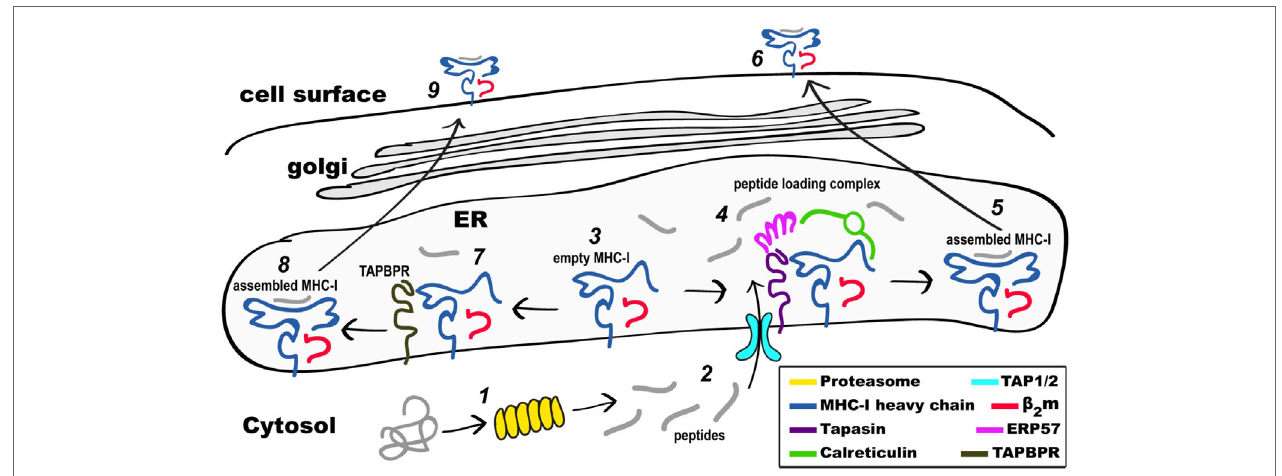
FiGURe 1 | Schematic view of MHC class I (MHC-I) pathways of antigen processing and presentation. Proteins in the cytosol engage the proteasome (1) and the peptides generated (2) are transported through the TAP1/2 transporter to the endoplasmic reticulum (ER). Partially folded MHC-I/ β 2-microgolobulin ( β 2 m) complexes (3) are stabilized as part of the peptide loading complex (PLC) (4) where they may be retained in a peptide-receptive state. Once high affinity peptide is bound, the peptide/MHC-I (5) is released from the PLC and destined for the secretory pathway and the cell surface (6). Alternatively, partially folded MHC-I/ β 2 m complexes (3) are stabilized by interaction with TAP-binding protein, related (TAPBPR) (7), loaded with peptide, released from TAPBPR (8), and the assembled MHC-I proceeds to the cell surface (9). Not illustrated are the peptide trimming enzymes (ERAAP or ERAP1/2) or the quality control UGGT1 interaction as described in the